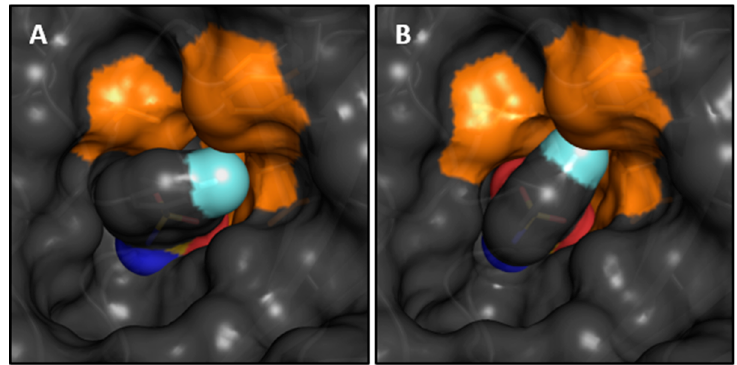
Figure 5. Hydrophobic pocket in orange, that accommodates meta and ortho fluorine substituents, exemplarily depicted with compounds 4 (left) and 6 (right) which adopt either the reference ( τ ~0°) or alternative conformation ( τ ~60°).